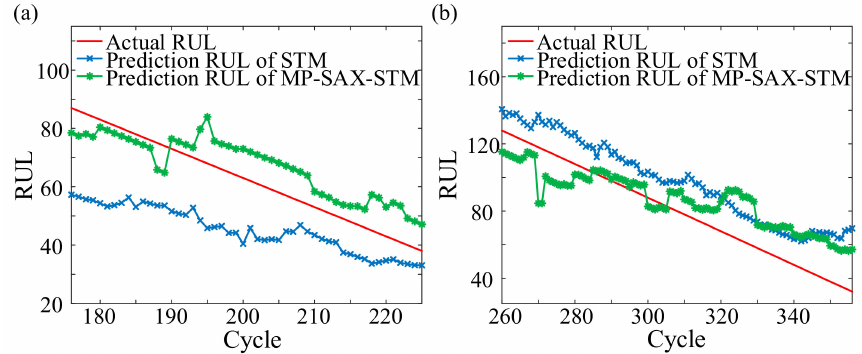
Figure 10. RUL result of the single tested sample. ( a ) Set #2. ( b ) Set #4.